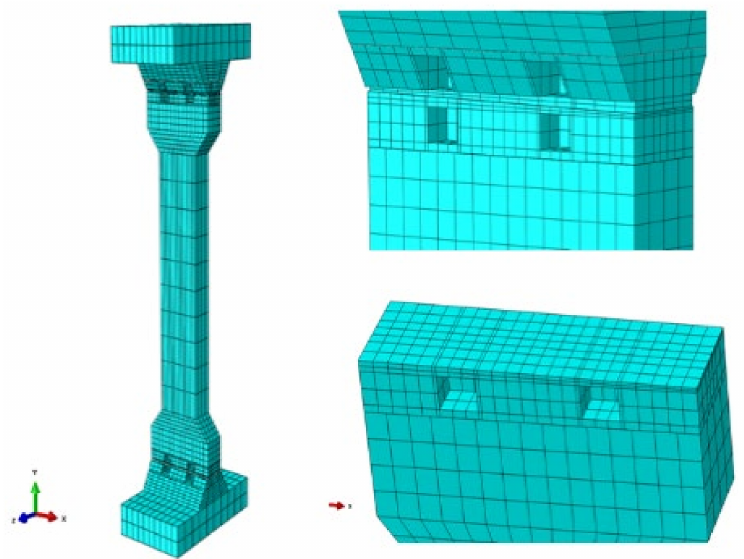
Figure 10. Grid division of the finite element